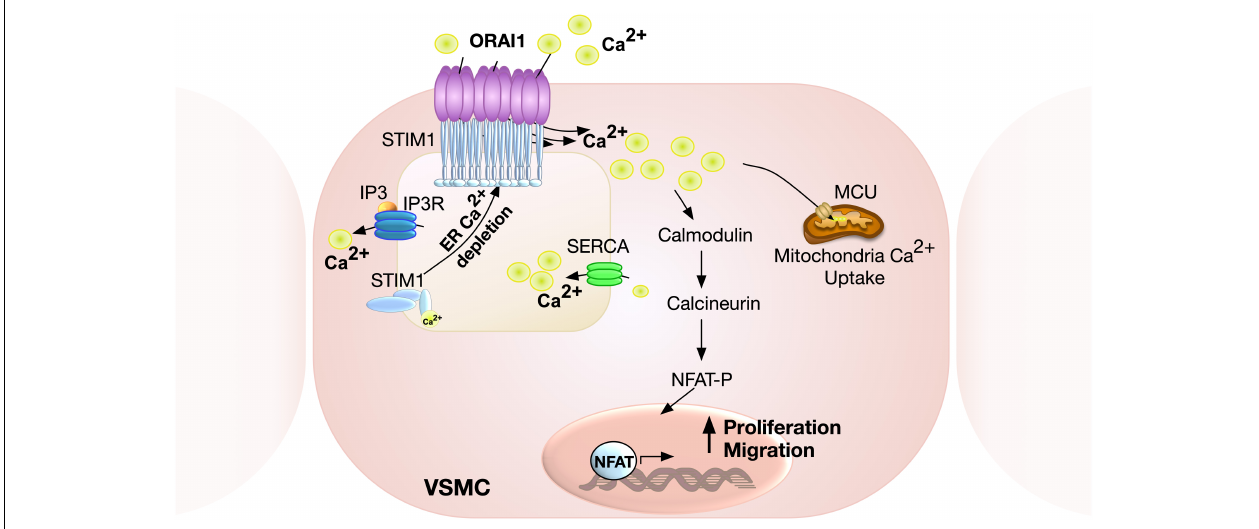
FIGURE 2 | Schematic representation of ORAI1-mediated SOCE in VSMC. Calcium release from ER via inositol 1,4,5-triphosphate (IP 3 ) receptor results in store depletion, which induces STIM1 oligomerisation to activate ORAI1 channels. ORAI1-mediated SOCE is associated with activation of nuclear factor of activated T-cell (NFAT), which promotes VSMC proliferation and migration. Ca 2 + influx via ORAI1 also induces mitochondrial Ca 2 + uptake via mitochondrial calcium uniporter